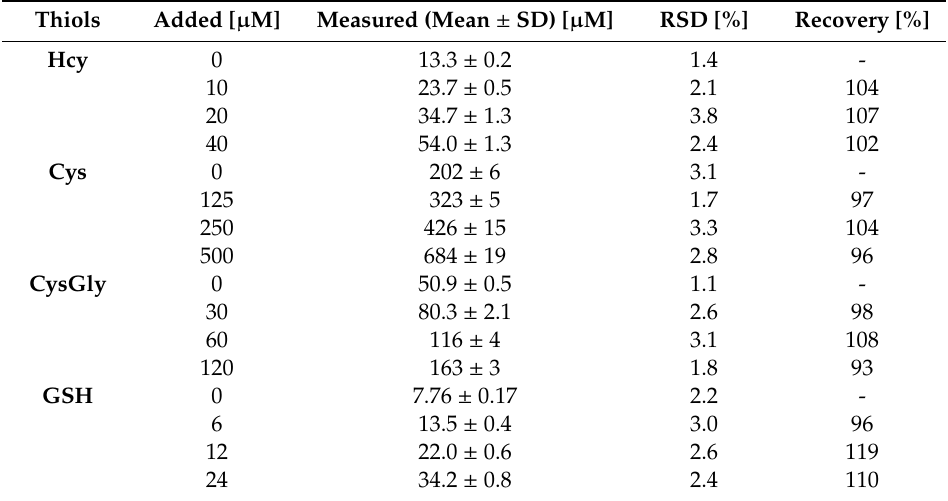
Table 2. Intra-day precision and recovery of thiols in mouse urine samples ( n = 5).